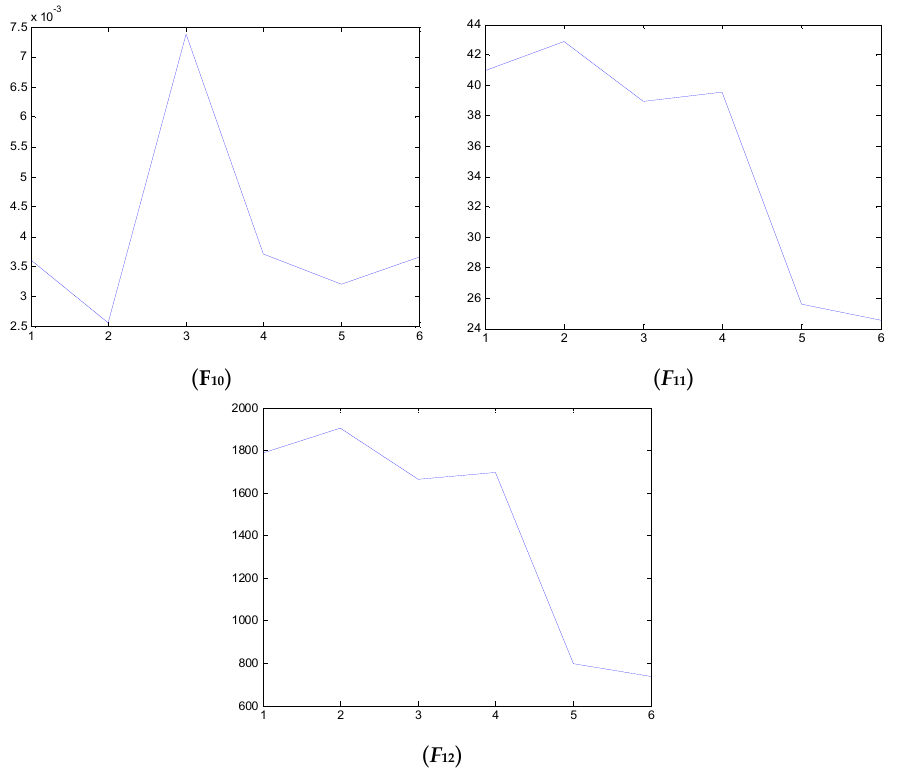
Figure 17. The analyzed results of A fan No. 2H sensor by F 10 , F 11 and F 12 .